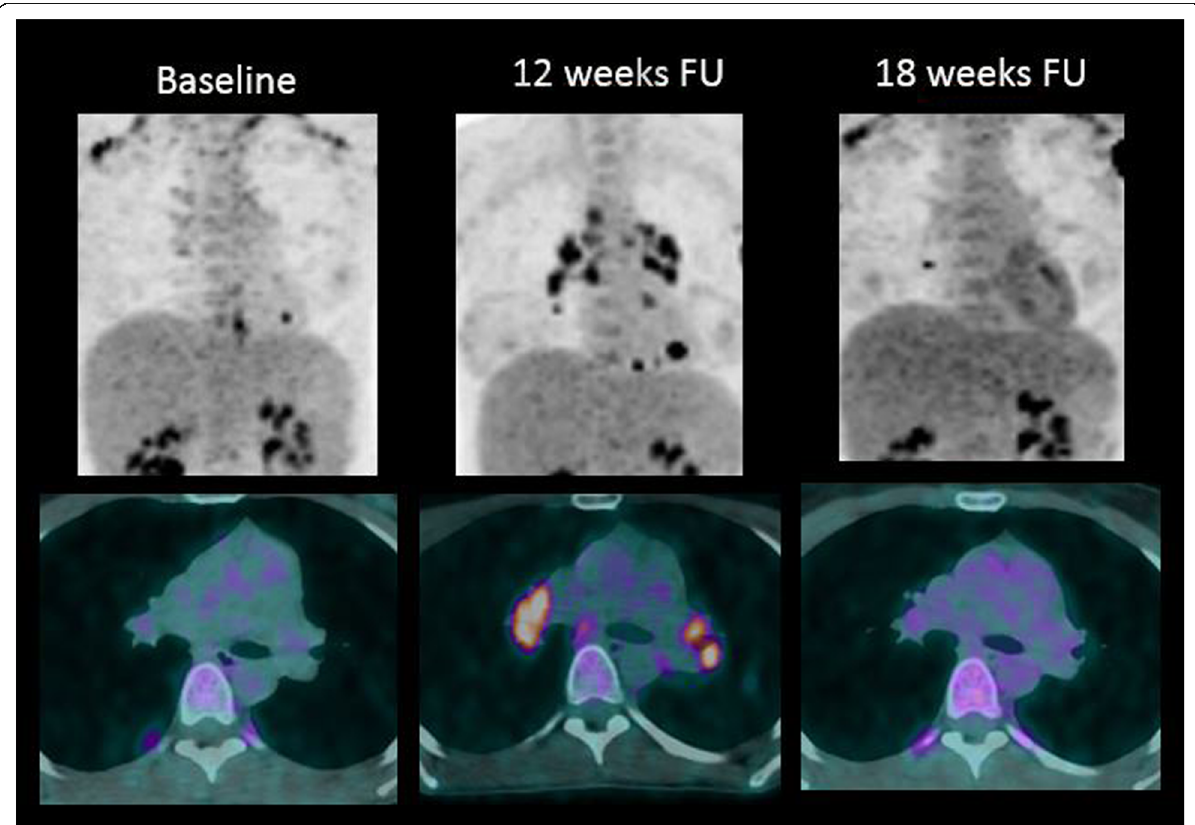
Fig. 7 Sarcoid-like reactions in a patient with metastatic melanoma treated with ipilimumab (antiCTLA-4) and nivolumab (anti-PD-1). Twelve-week follow-up (FU) 18 F-FDG PET/CT images show typical hypermetabolic symmetric mediastinal and hilar lymph node enlargement, very suggestive of a sarcoid-like reaction. These features disappeared on the following 18 F-FDG-PET/CT images at 18-week FU, confirming the diagnosis of sarcoid- like reaction under